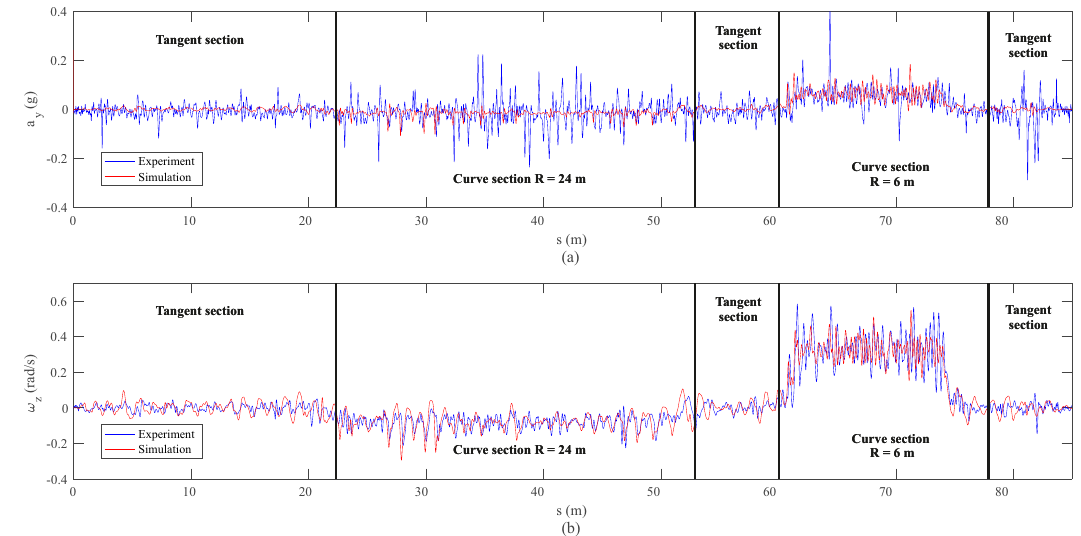
Figure 17. Lateral acceleration ( a ) and yaw angular velocity ( b ) data from inertial sensors on the wheelset.